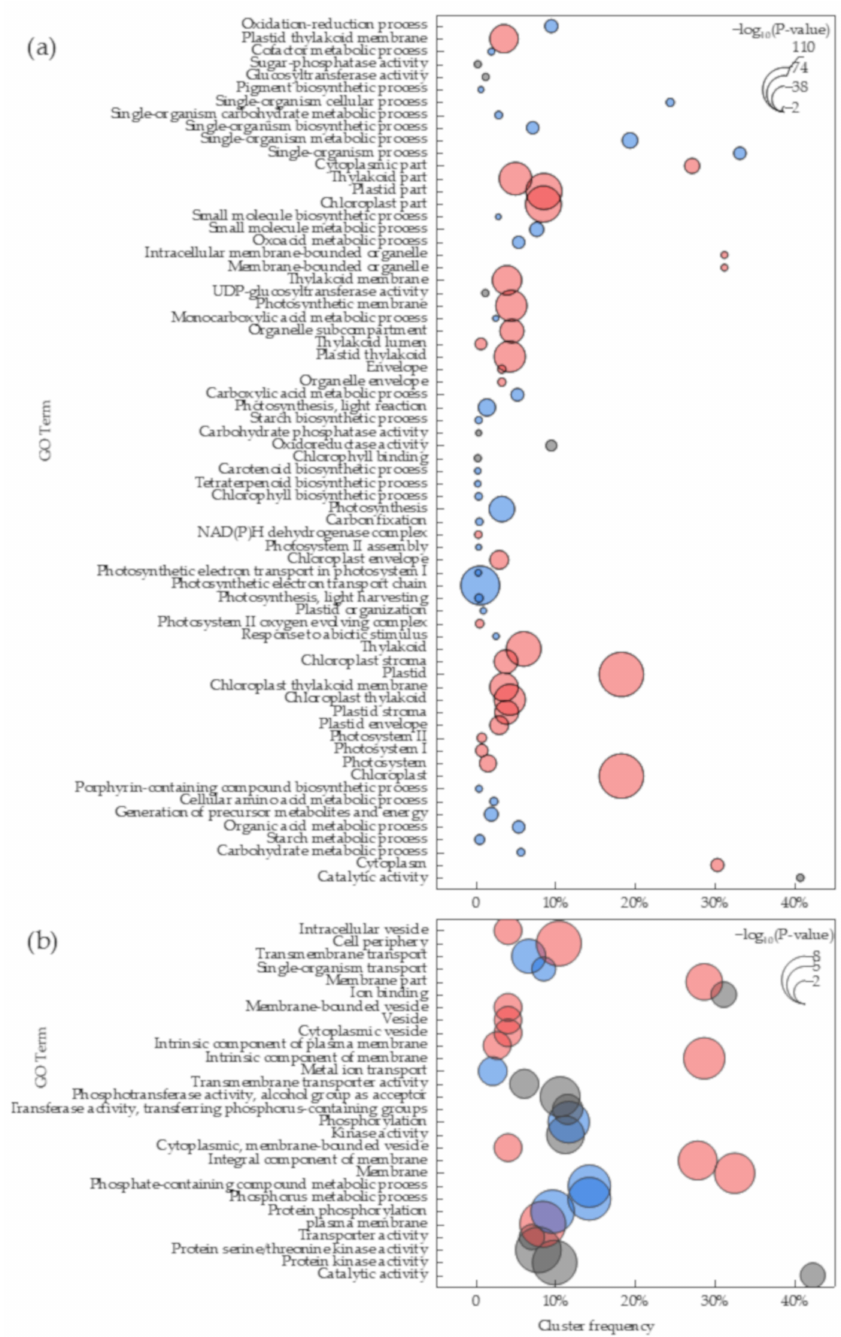
Figure 1. Enrichment analysis of GO between SS/SC ( a ) and TS/TC ( b ). The red, blue, and gray colors represent cellular component, biological process, and molecular function, respectively. Cluster frequency is the proportion of DEGs annotated to a term to the total DEGs annotated to GO